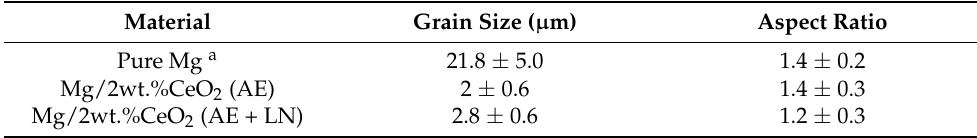
Table 2. Results of grain size analysis for Mg/2wt.%CeO 2 composite before and after DCT.